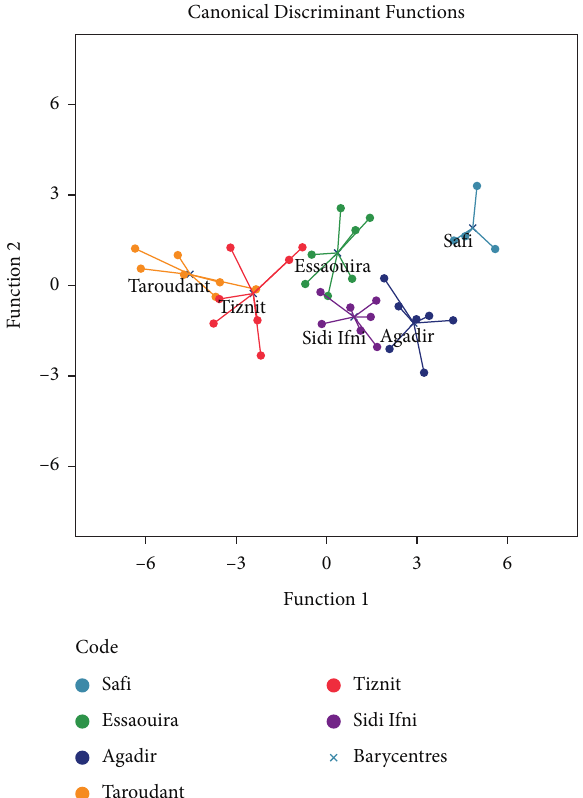
Figure 5: Linear discriminant analysis based on the tocopherols amount of 39 samples from six different